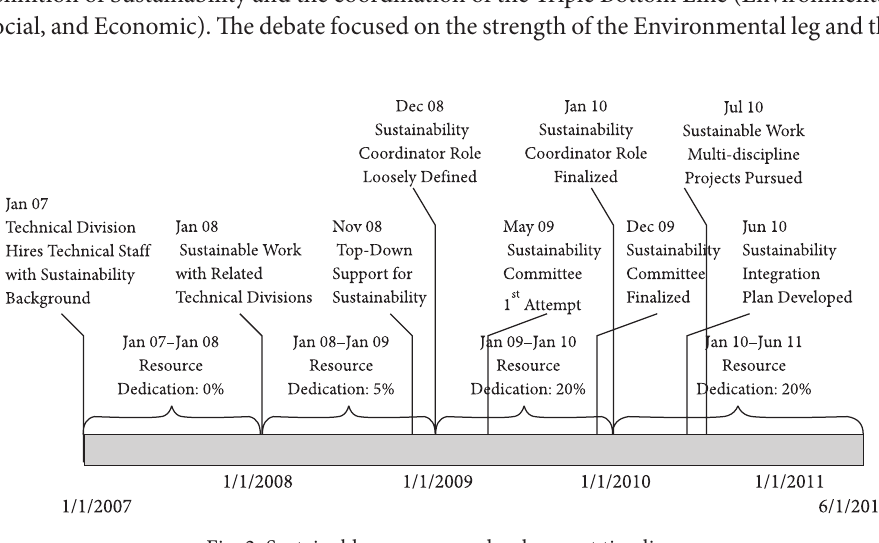
Fig. 2. Sustainable governance development